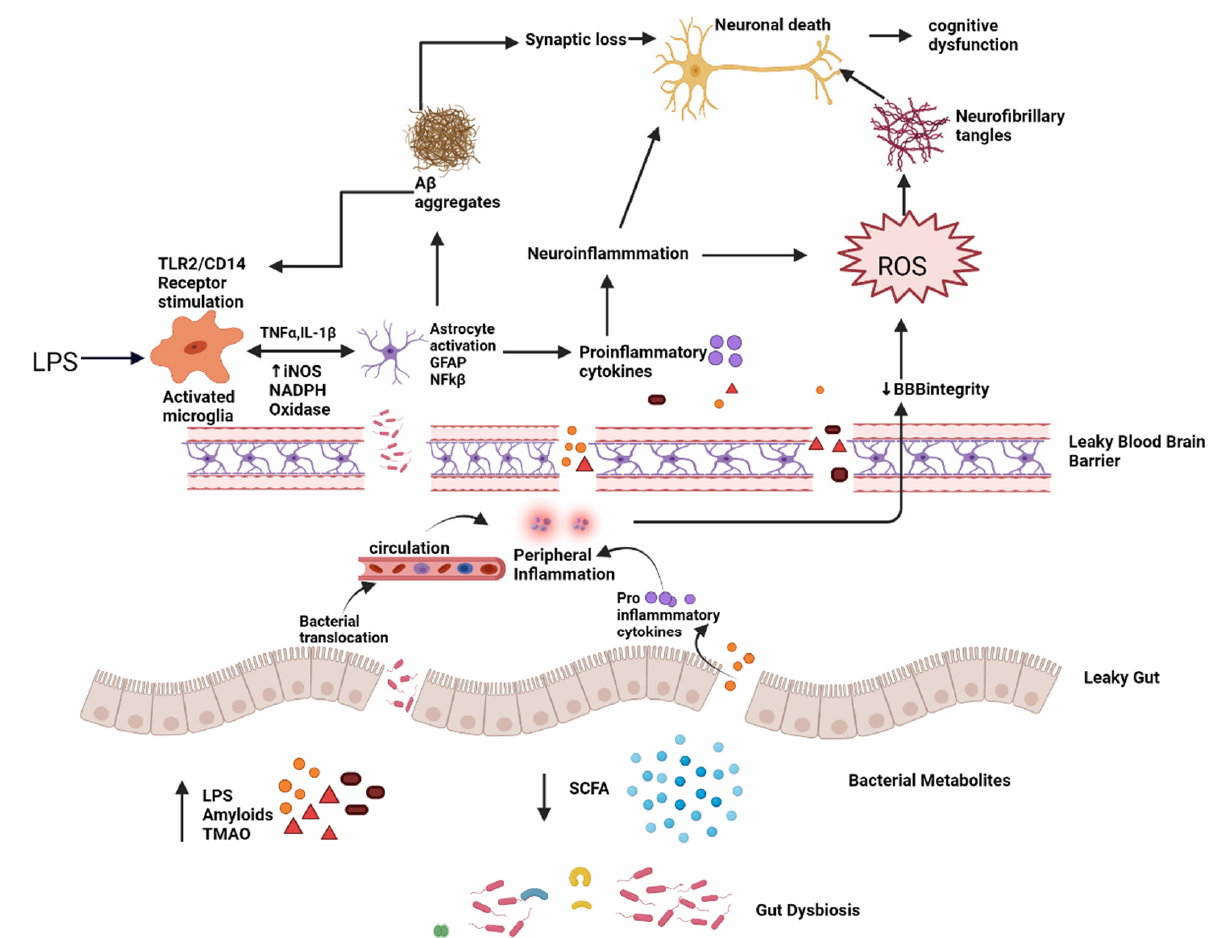
Figure 5. Dysbiosis and Alzheimer’s disease; intestinal permeability is harmed when gut equilibrium is disrupted by pro-inflammatory microorganisms that produce bacterial amyloids, LPS, TMAO and decrease beneficial bacterial metabolites, such as SCFA. Impairment in the gut and blood–brain barrier leads to the increased invasion of microbes into peripheral and CNS and in- crease production of pro-inflammatory cytokines and thus causing peripheral and central inflam- mation. This neuroinflammation leads to neuronal death directly and through ROS which leads to the formation of neurofibrillary tangles. LPS also acts on TLR2/TLR4 CD14 receptor on activated microglia, increasing TNF- α , IL-1 β , iNOS, NADPH oxidase, and thus astrocyte activation and NF- kB activity which further promote A β aggregation. A β also acts as an agonist to the TLR4 receptor and thus promotes the vicious cycle of amyloid aggregation and ultimately neuronal death in AD.